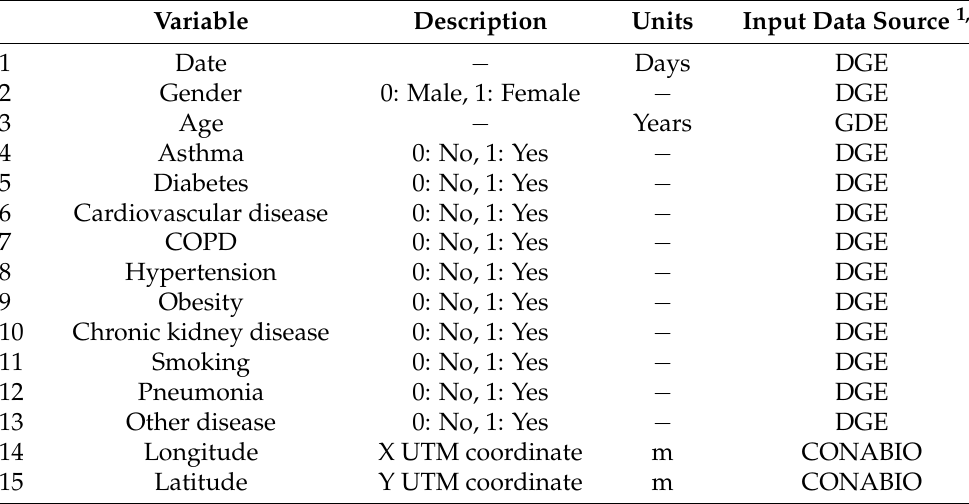
Table 1. Explanatory variables used in the